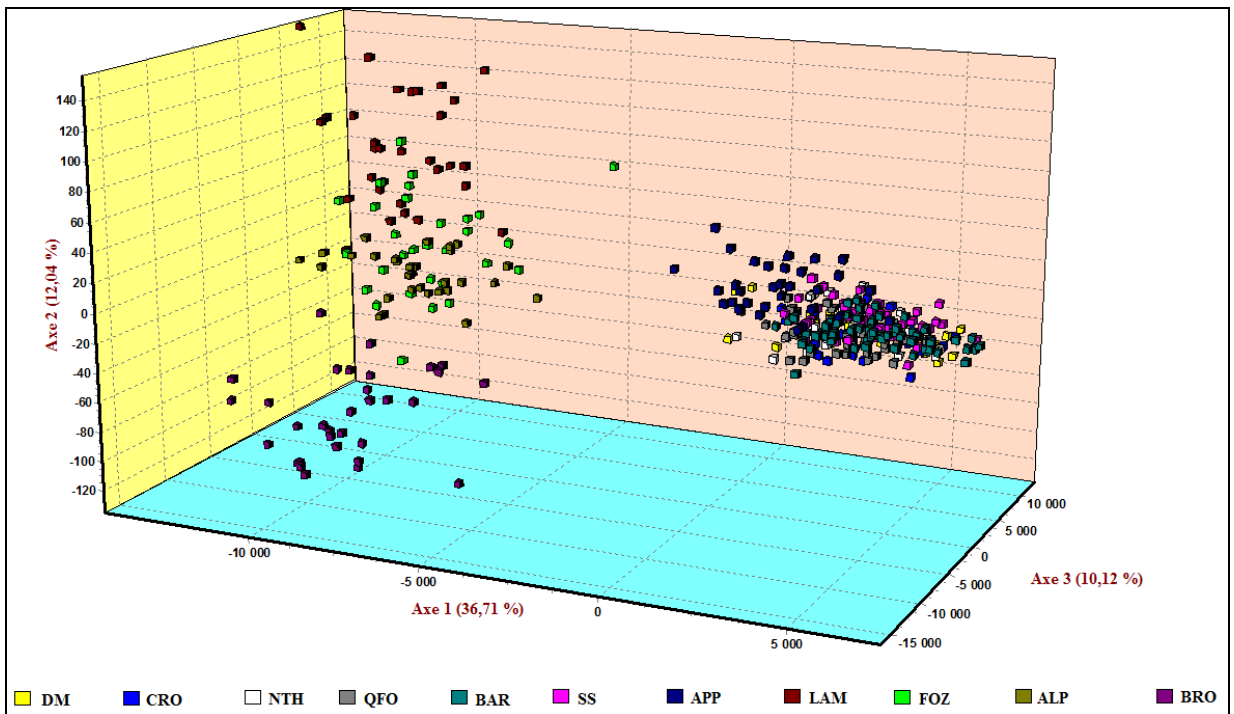
Figure 1. Spatial representation of the Mediterranean-analyzed native sheep breeds as defined by factorial correspondence analysis. Tunisian breeds: Barbarine (BAR), Queue Fine de l’Ouest (QFO), cross-bred BAR × QFO (CRO), D’man (DM), Sicilo-Sarde (SS), Noire de Thibar (NTH); Venetian breeds: Alpagota (ALP), Brogna (BRO), Foza (FOZ), and Lamon (LAM); Central Italian breed: Appenninica (APP).